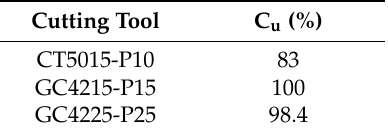
Table 8. Coefficient of use of the cutting tools.